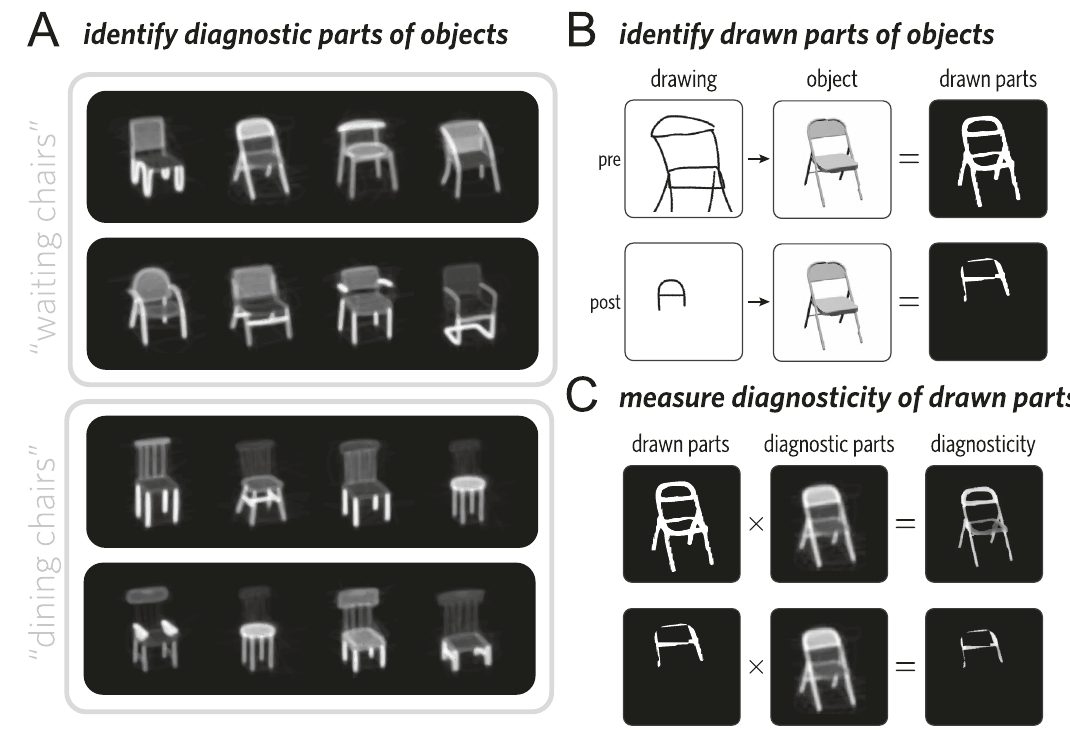
Fig. 6 | Analysis pipeline for evaluating visual diagnosticity. A Annotators indicated which parts of an object were most diagnostic in context (brighter regions are more diagnostic), yielding a graded diagnosticity heatmap for each object. B Aseparategroupofannotatorsalsoindicatedwhichpartsofobjectswere depictedineachdrawing,yieldingabinaryimagemaskforeachdrawing.Imagesof